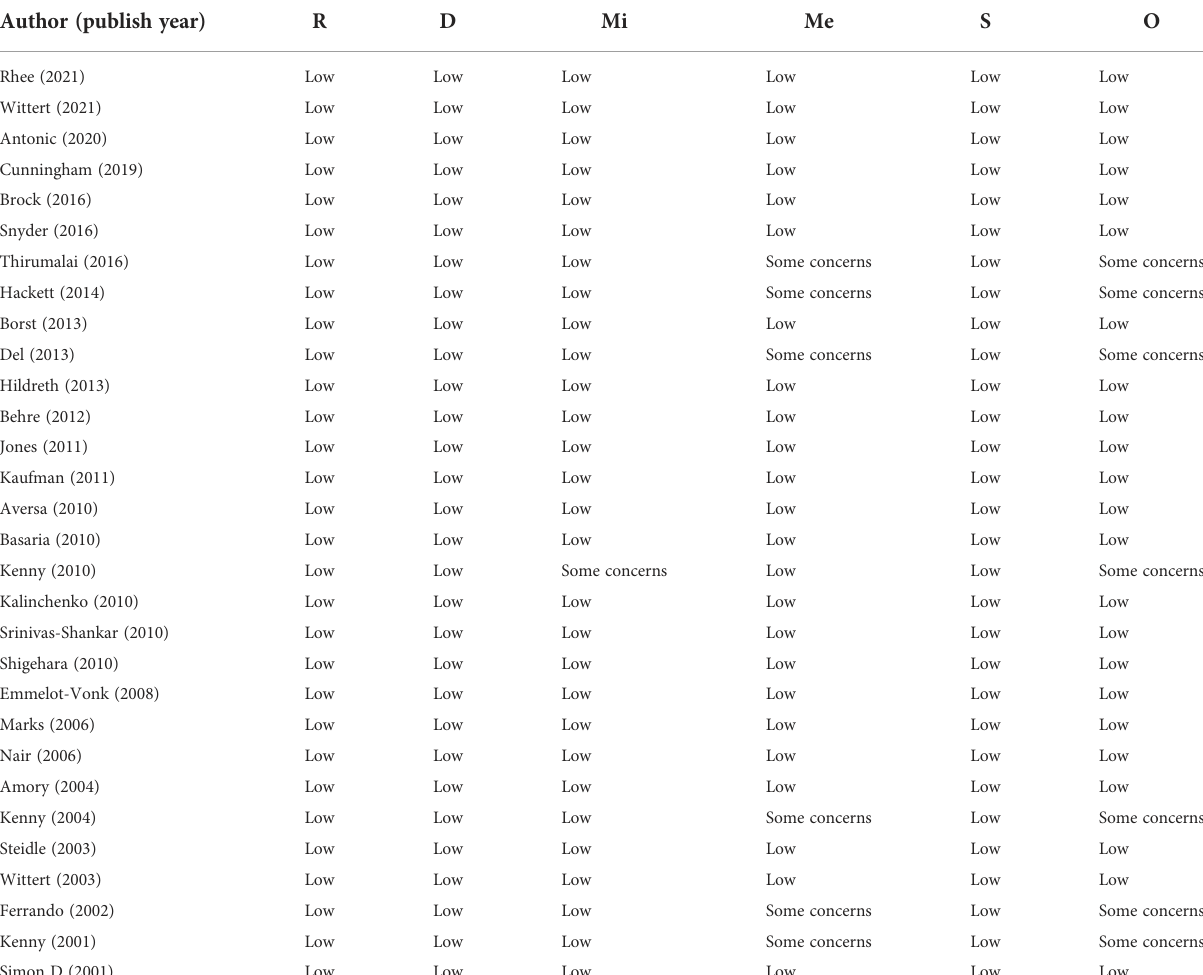
TABLE 2 Quality assessment of individual RCT.